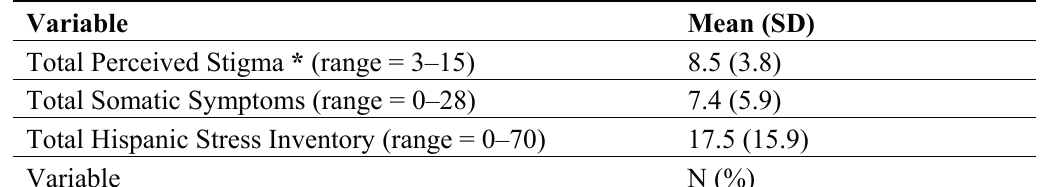
Table 1. Baseline Demographics (n =